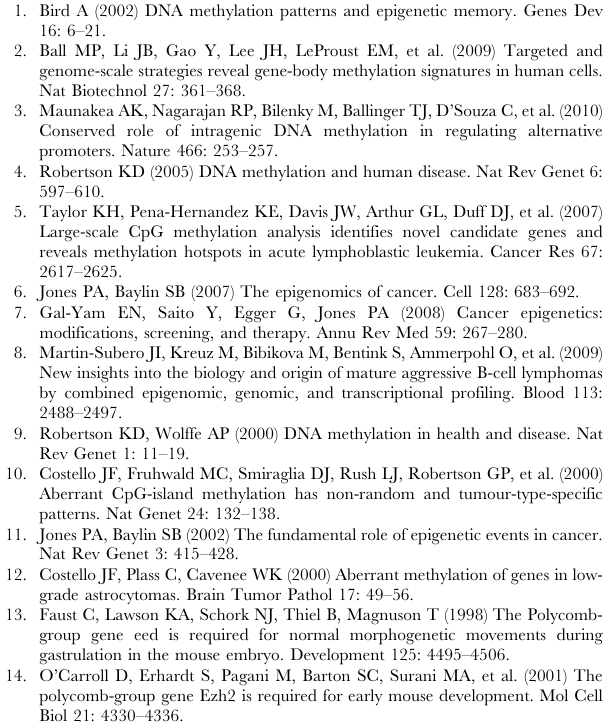
Figure S1 Verification of successful bisulfite conversion: The figure shows the pyrosequencing trace of the sample CRC-TU at the SMAD7 locus (chromosome 18, position was used for the sequencing and an analysis pipeline presented in the manuscript, was analysed with bisulfite pyrosencing. For the internal bisulfite control position a ‘‘c’’ is injected before and after the converted ‘‘t‘‘. No light signals were obtained for these positions demonstrating complete and successful bisulfite conversion. Figure S2 The figure provides the rationale for choosing 95% sequence identity as a criterion for the selection of converted amplicon reads in the analysis. The dashed line shows the frequency of reads with the identity to the predicted amplicon sequence on the x-axis. The 95% criterion that is custo- mary for unconverted SNP discovery experiments thus appears to be suitable for the converted amplicons as shown in the solid lines. Table S1 Overview analysed regions. For some of the smaller regions only manual design using previously designed or only automatic design was attempted. Regions, where the respective design method was not used are indicated by ‘‘n/a’’. The large hepityping regions were only processed through the automated pipeline. The coordinates are given according to NCBI build 36.1 (UCSC hg18). The empirical coverage by sequencing reads exactly corresponds to the theoretically expected one and is thus not provided separately. Table S2 List of all primer pairs and amplicon yield in the experiment: The primer sequences and target genes are provided. The mean number of aligned finished reads for